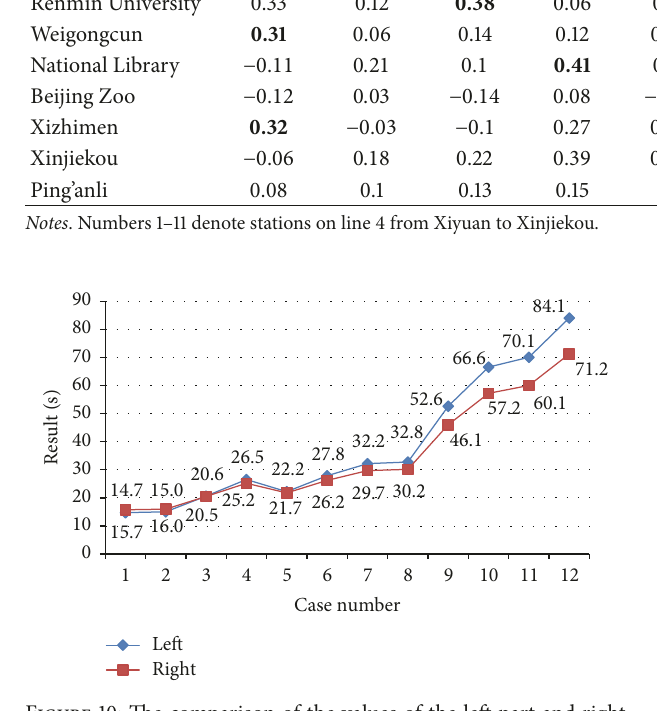
Figure 10: The comparison of the values of the left part and right part in formula